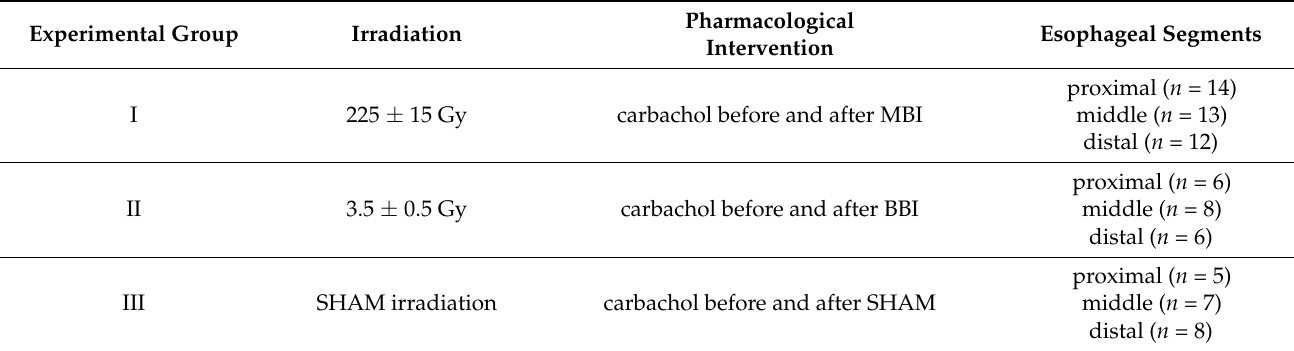
Table 1. Three experimental